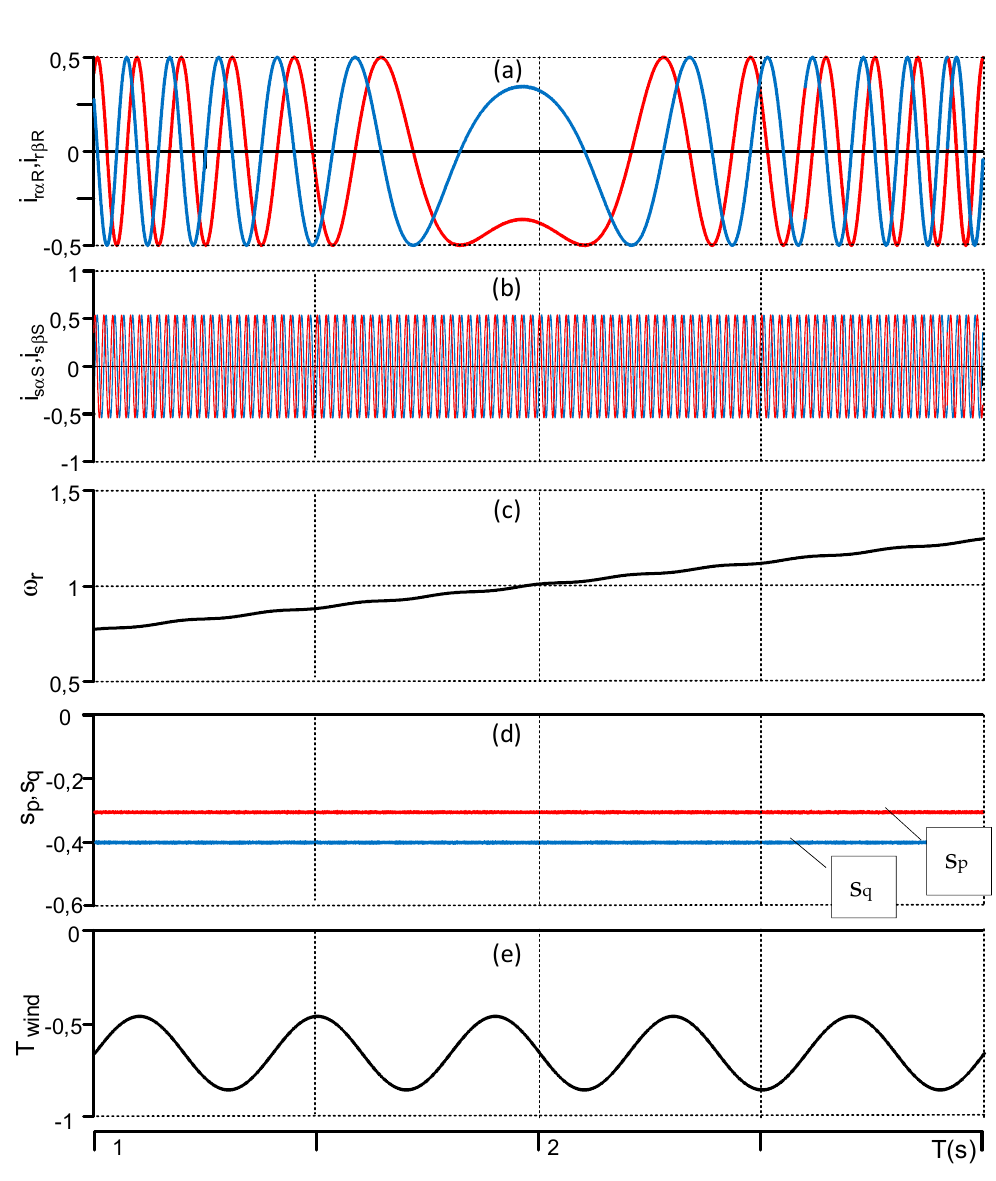
Figure 7. DFIG system behaviour during changes of the rotor speed from under-synchronous to over-synchronous with constant reference active and reactive powers. ( a ) Rotor current vector components; ( b ) stator current vector components; ( c ) rotor speed; ( d ) active and reactive powers; ( e ) drive torque.